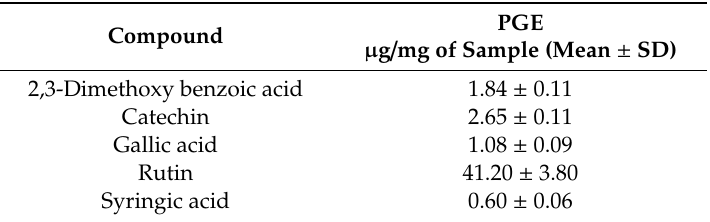
Table 2. HPLC-PDA analysis of phenolics identified in the ethyl acetate extract, obtained by Soxhlet from the waste peel of Punica granatum L. var. Dente di Cavallo DC2 (PGE) ( n = 3).